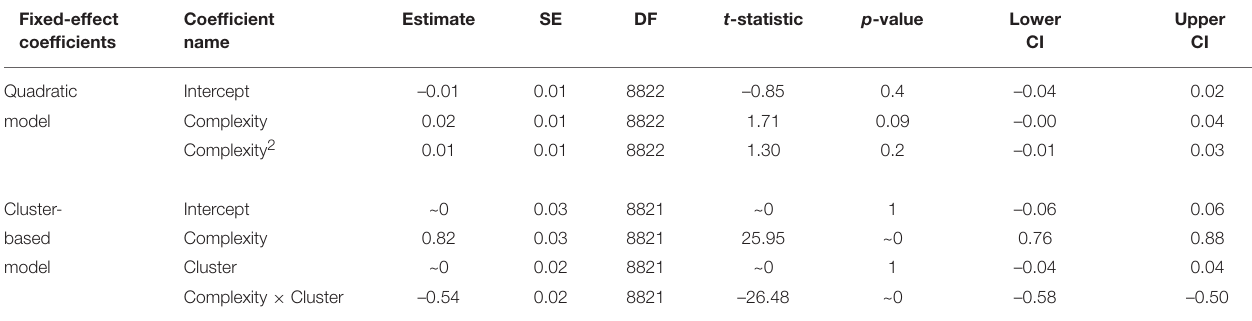
TABLE 1 | Estimated fixed-effect coefficients of the quadratic and cluster-based models.